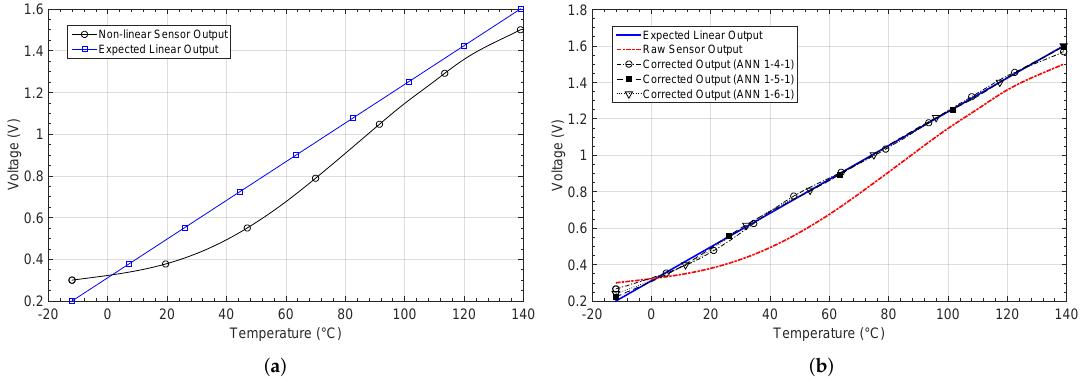
Figure 10. Thermistor output characteristic NL1 ( a ) before and ( b ) after